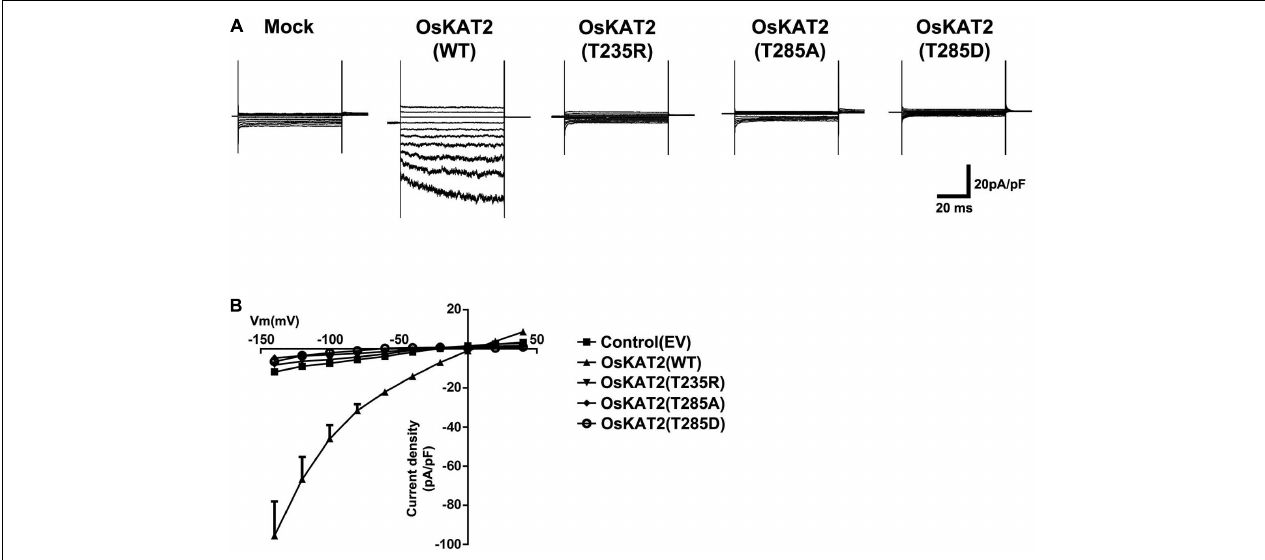
FIGURE 2 | Patch-clamp analysis to measure channel activity in the OsKAT2 single amino acid mutants. (A) Representative current traces show the channel activity of each OsKAT2 protein. HEK293 cells with empty vector (EV, pcDNA6.2-EmGFP) or expression constructs for wild-type OsKAT2, OsKAT2(T235R), OsKAT2(T285A), or OsKAT2(T285D) were recorded by whole-cell patch-clamp analysis. Currents were obtained by changing the membrane voltage from a holding potential of –20 mV following test pulses from –140 to + 60 mV in 20 mV increments. (B) Steady-state I–V relations of current density collected at the end of the test pulse (lower panel). Results are means ± standard error